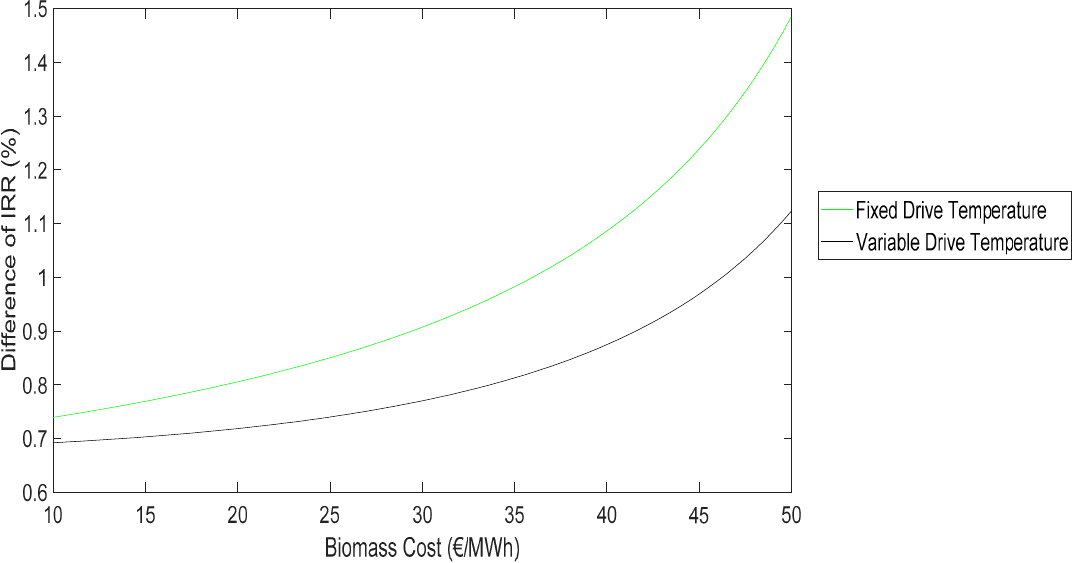
Figure 12. Influence of the cost of biomass on IRR difference between a network of low and medium temperature, with fixed and variable operating temperatures of the network.